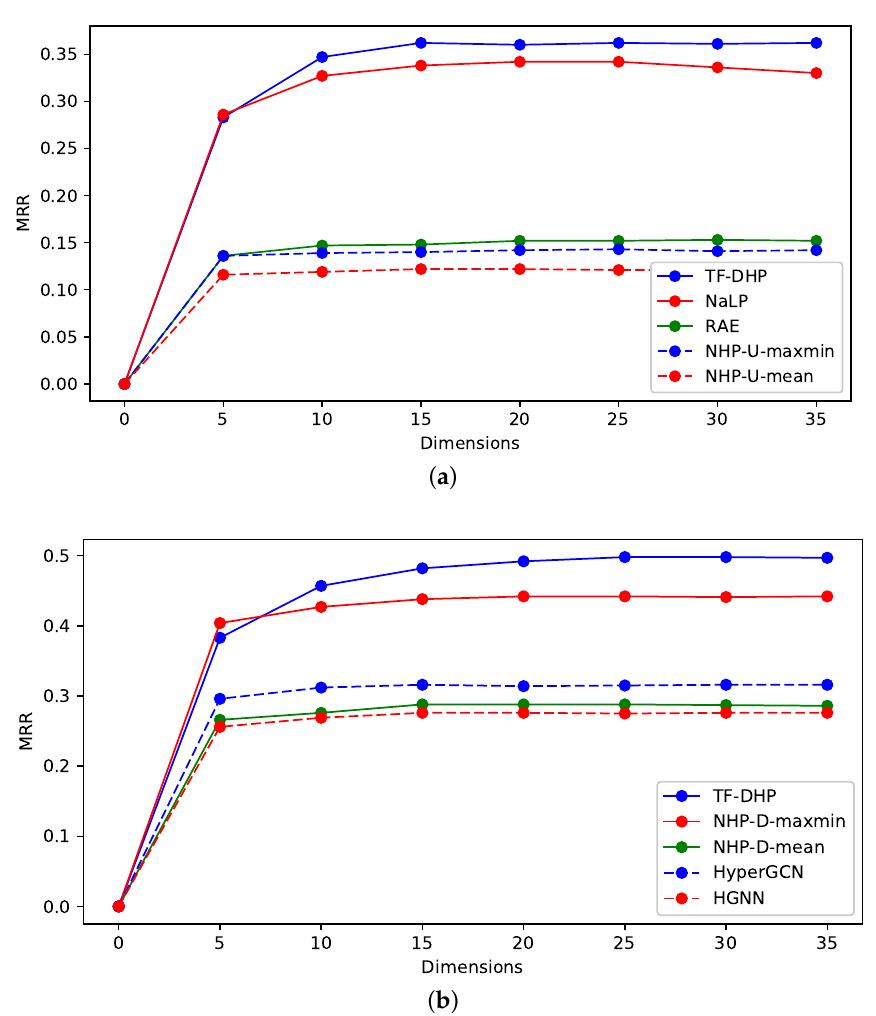
Figure 5. MRR over different embedding sizes of undirected hyperlink prediction models and directed hyperlink prediction models, evaluated on WikiPeople and Reverb15k: ( a ) undirected hyperlink prediction models; ( b ) directed hyperlink prediction